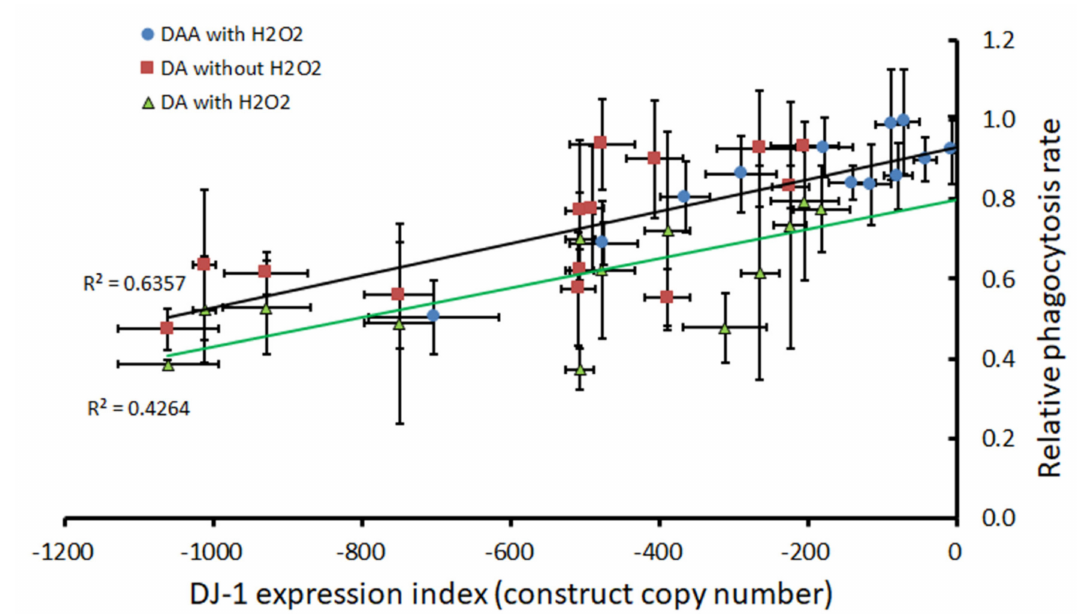
Figure 4. The effect of oxidative stress, DJ-1 and AMPK knockdown on phagocytosis. Phagocytosis rates of DJ-1 antisense (DA) and DJ-1/AMPK double antisense (DAA) cotransformants exposed to H 2 O 2 , compared to DJ-1 antisense transformants without exposure to H 2 O 2 . The phagocytosis rates were measured as the rate of uptake in shaken suspension of DS-Red- expressing (fluorescent) E coli cells (bacteria taken up per amoeba per hour), normalized to those measured in the same experiment for the parental strain AX2. These were plotted against the DJ-1 expression index measured as per the previously established convention of using the negative of the antisense inhibition construct (pPROF688) copy numbers [18]. Error bars are standard errors of the mean from 3 independent experiments. The results for DJ-1 knockdown (DA) without H 2 O 2 were previously described [18] (Supplementary Figure S4). R2 represents the fraction of the variance in expression that was attributable to the regression relationship. Multiple regression analysis was performed to determine the significance of regression parameters and lines were fitted by linear least squares to pass through the intercepts derived therefrom (Supplementary Table